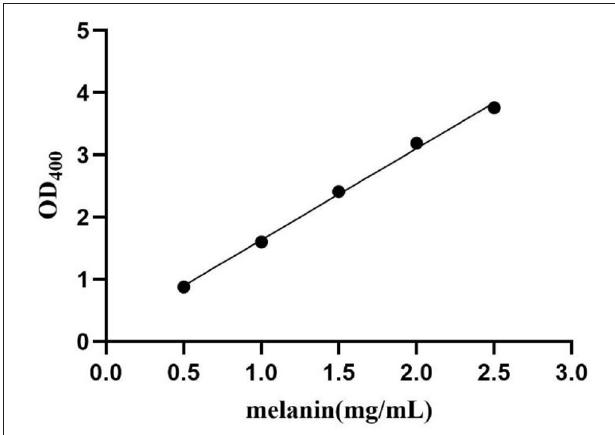
FIGURE 1 | Standard curve of melanin. The formula is Y = 1.471*X + 0.1627, R 2 = 0.9969.